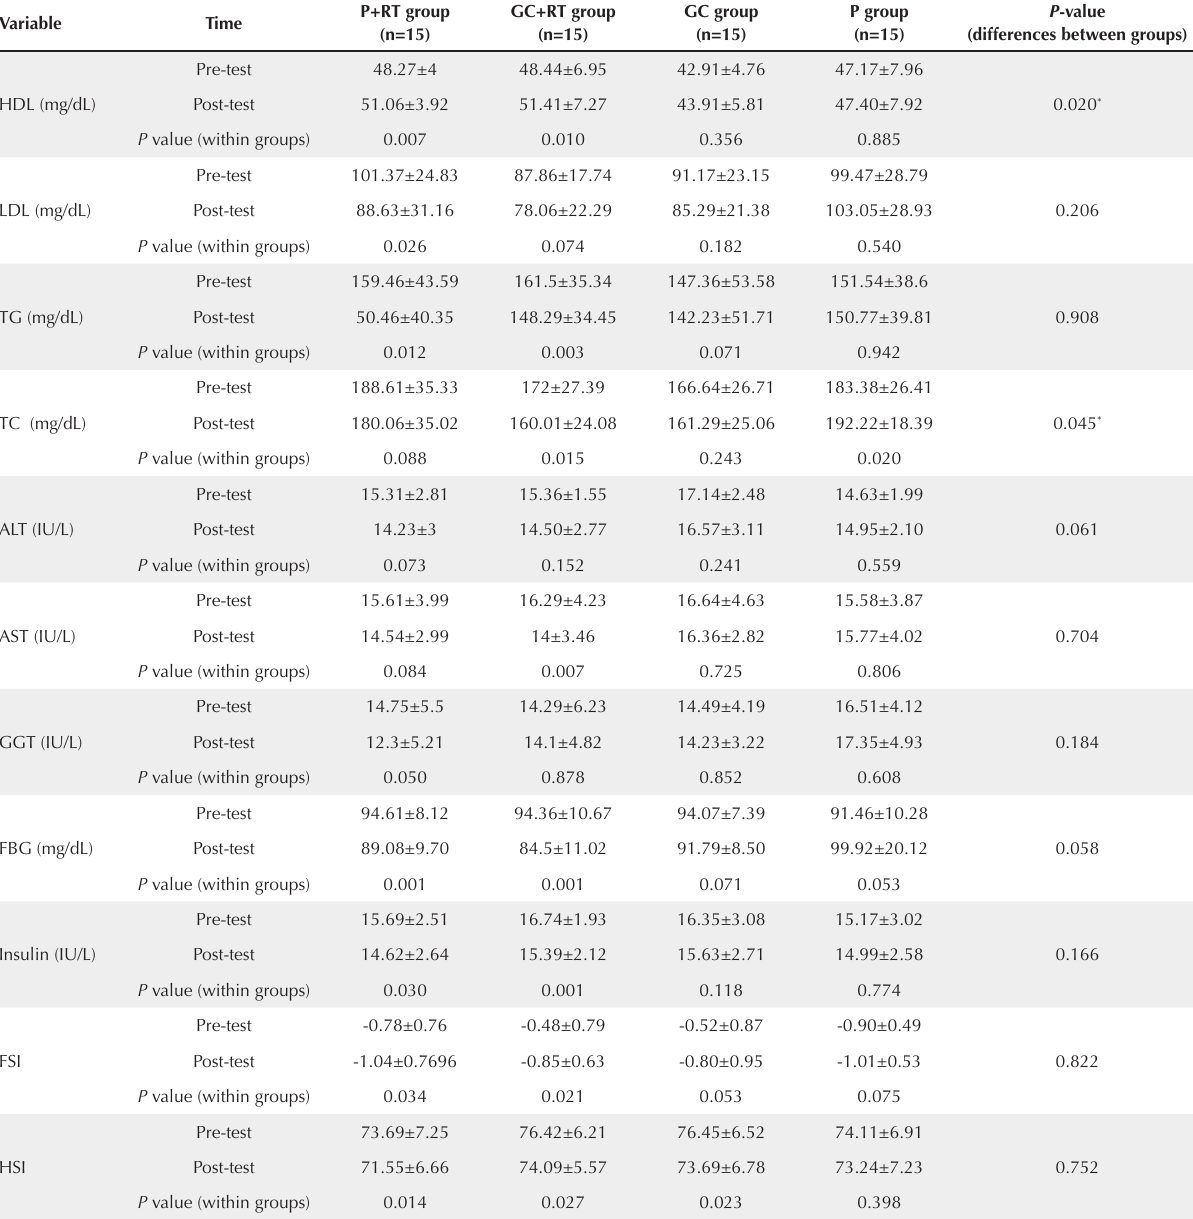
Table 3. Comparison of Changes in Biochemical Biomarkers between Groups after 8 Weeks of Intervention